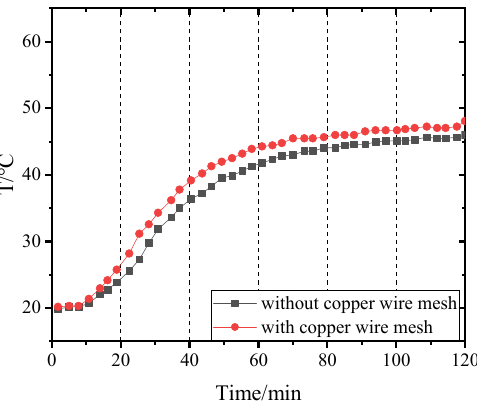
Figure 17. Temperature of point 4 in PCM-1 changing with time.